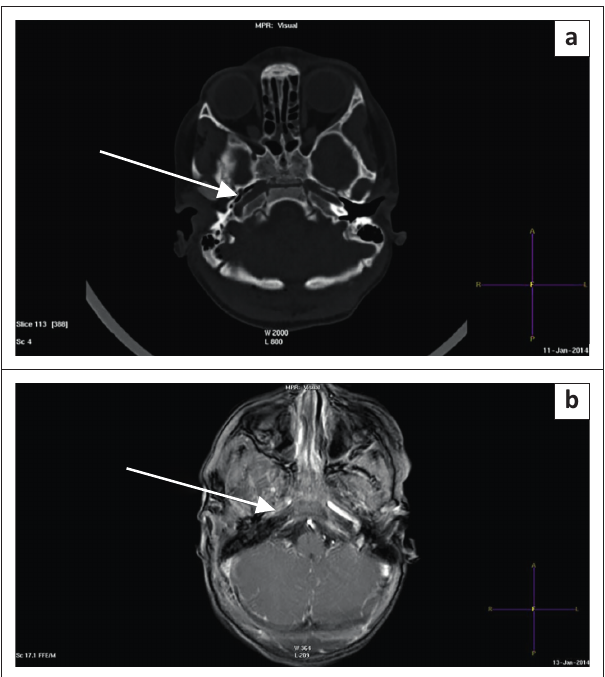
FIGURE 6: (a) A 5 year old boy presented with epistaxis, vomiting and a GCS of 12, following blunt trauma. Axial CT bony algorithm demonstrated a right base- of-skull fracture, with air tracking along the right carotid canal (white arrow); (b) Axial T1 post contrast MRI of the brain shows a filling defect in the right petrous segment of the ICA (white arrow), in keeping with subacute thrombus secondary to dissection.